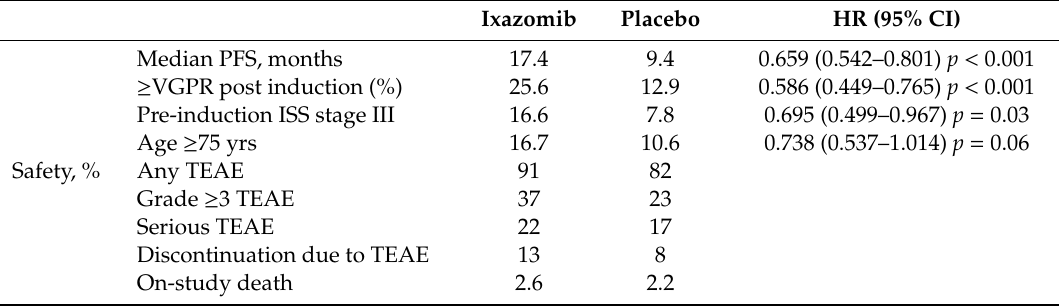
Table 2. E ffi cacy and safety data from the TOURMALINE-MM4